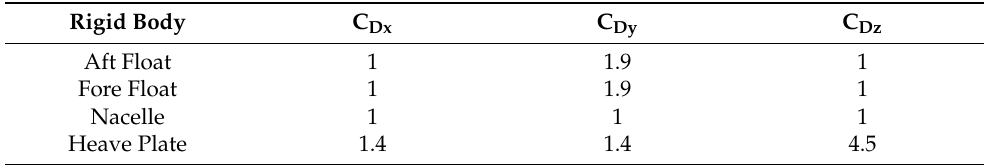
Table 1. Wave Energy Buoy that Self-deploys Viscous Drag Coefficients for a z-vertical coordinate